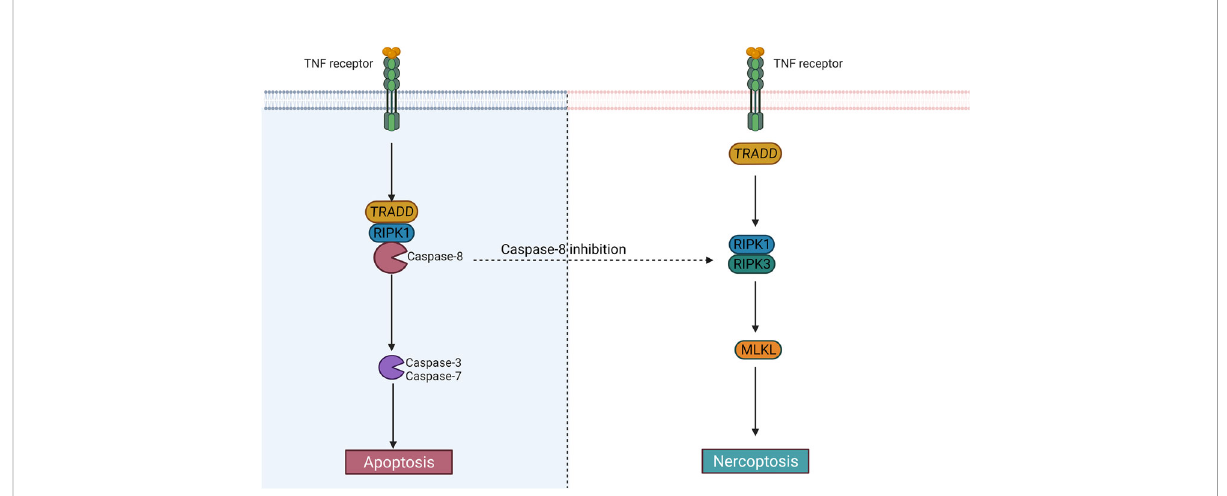
FIGURE 3 The difference between apoptosis and necroptosis. Caspase-8 largely determines whether cells undergo an apoptotic or necrotic program. After activation of caspase-8, the cells may undergo apoptosis; When it is inhibited, the cells may become